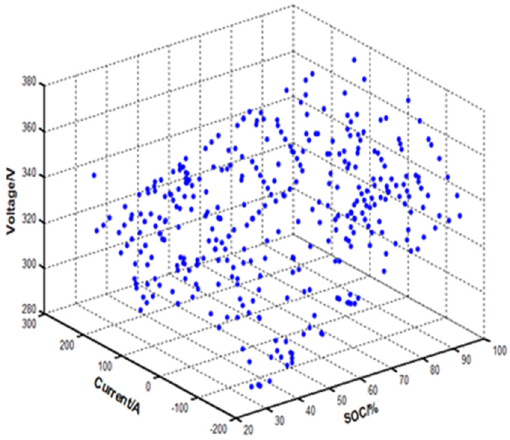
Figure 6. Corresponding relationship between three parameters.